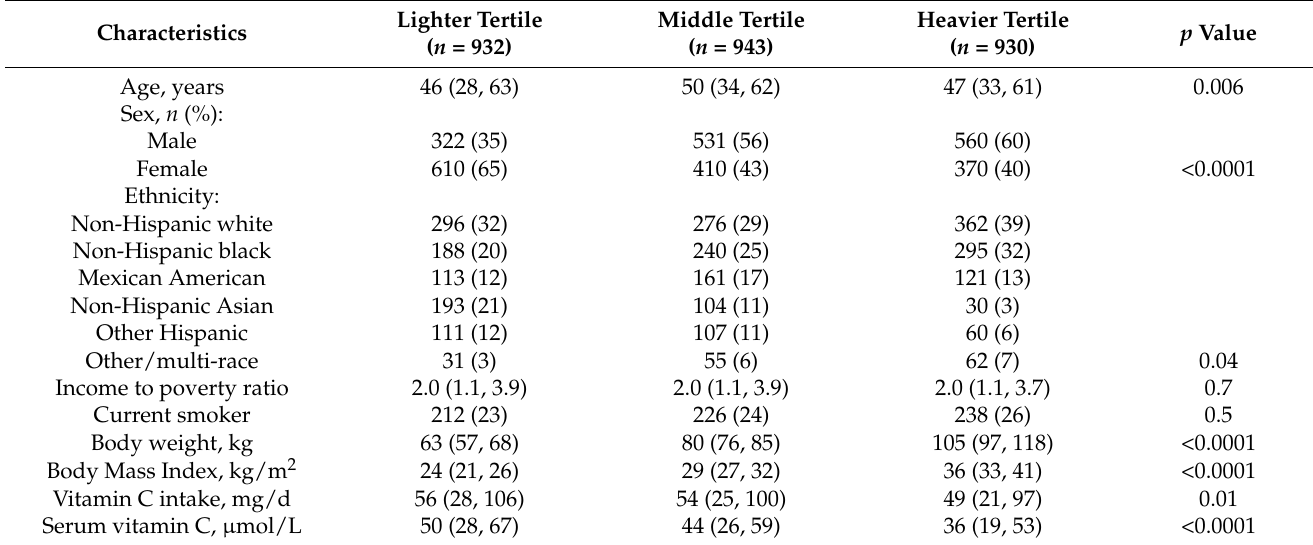
Table 4. Cohort characteristics stratified by body weight